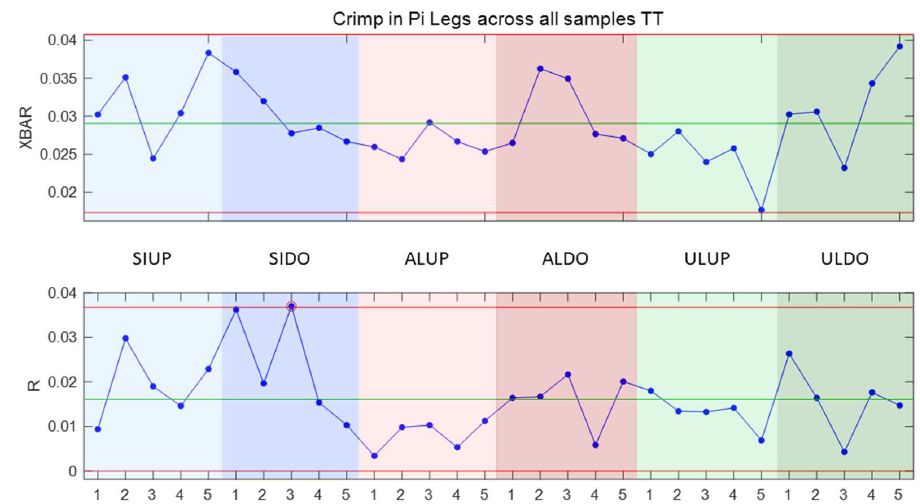
Figure 12. Control chart to represent variation in crimp of Pi legs across all samples TT.